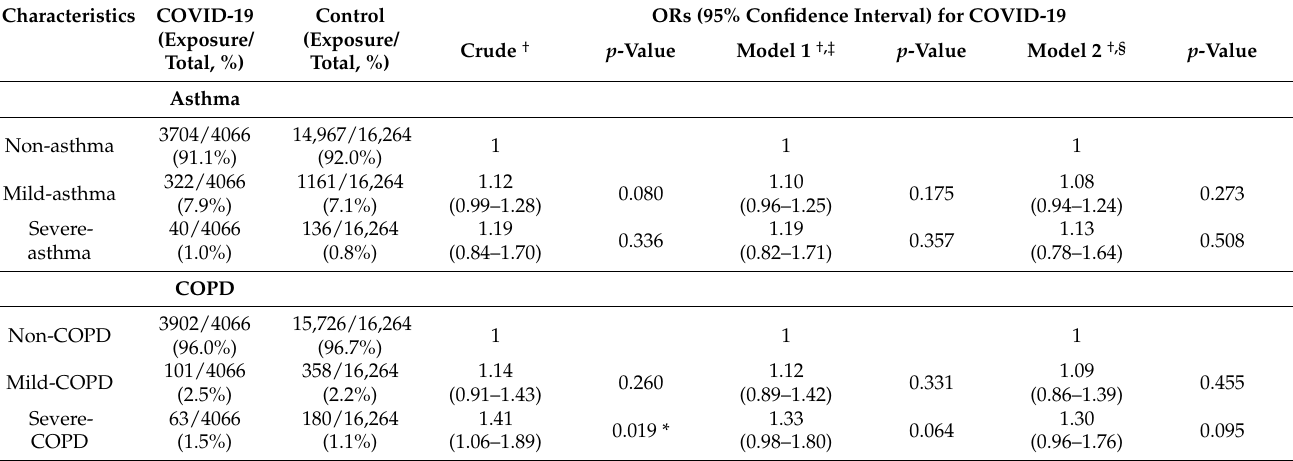
Table 2. Crude and adjusted odds ratios of asthma and COPD for COVID-19 in total